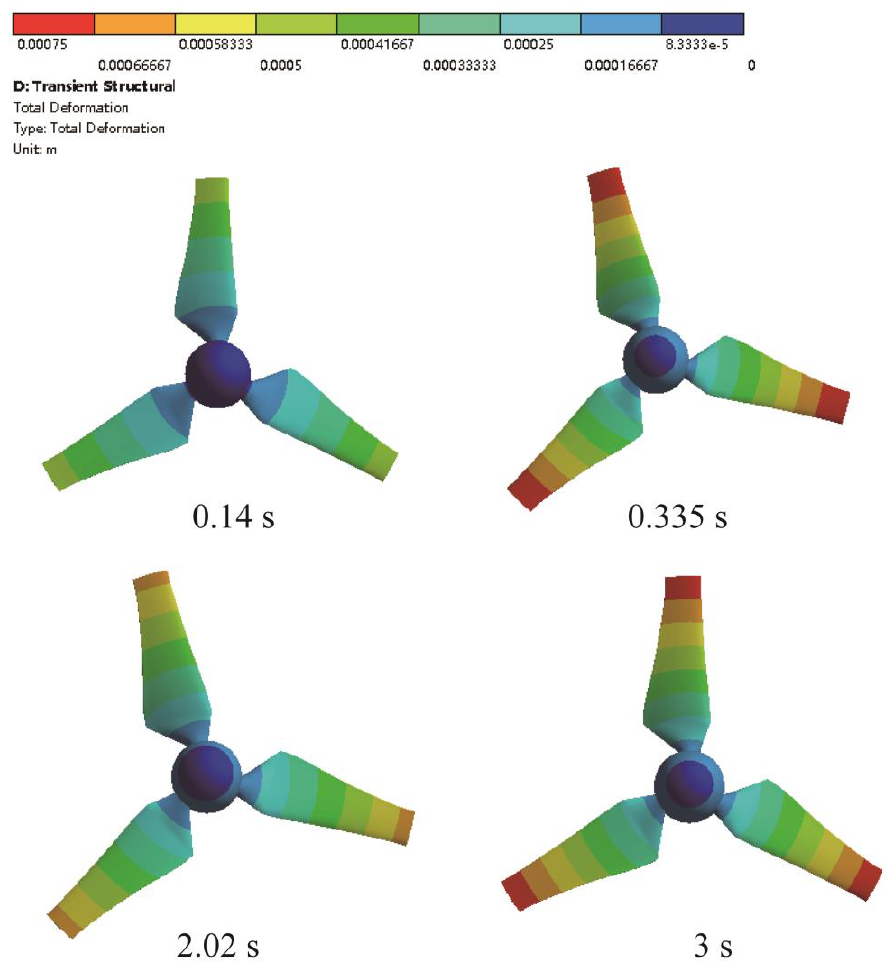
Figure 9. Distribution of blade deformation at different times (m).